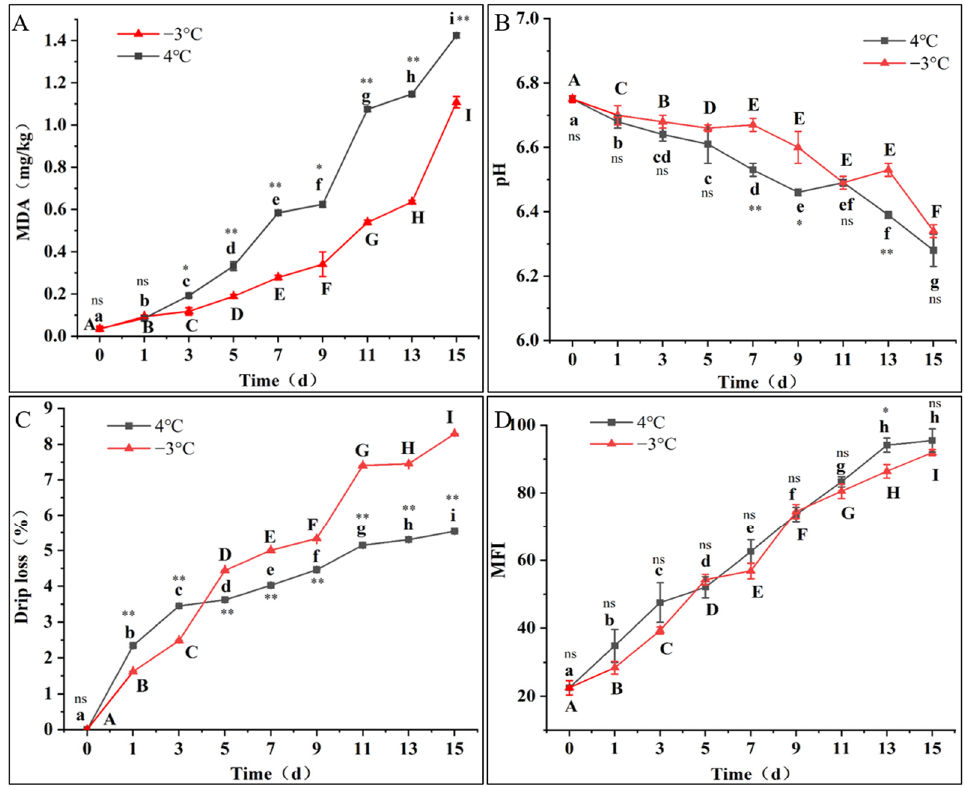
Figure 1. Changes in MDA content ( A ), pH ( B ), drip loss ( C ), and MFI ( D ) of Coregonus peled fillets during 4 °C refrigeration and − 3 °C super chilling storage for 15 d. Note: The different letters represent a significant difference between samples by time storage ( p < 0.05); different uppercase letters (A–I) indicate significant differences ( p < 0.05) for − 3 °C super chilling. Different lowercase letters (a–i) indicate significant differences ( p < 0.05) for 4 °C refrigeration. Significantly different values as influenced by storage temperature: * ( p < 0.05); ** ( p < 0.01); ns: no significant difference ( p > 0.05). Specific numerical data are in the Supplementary Table S1.